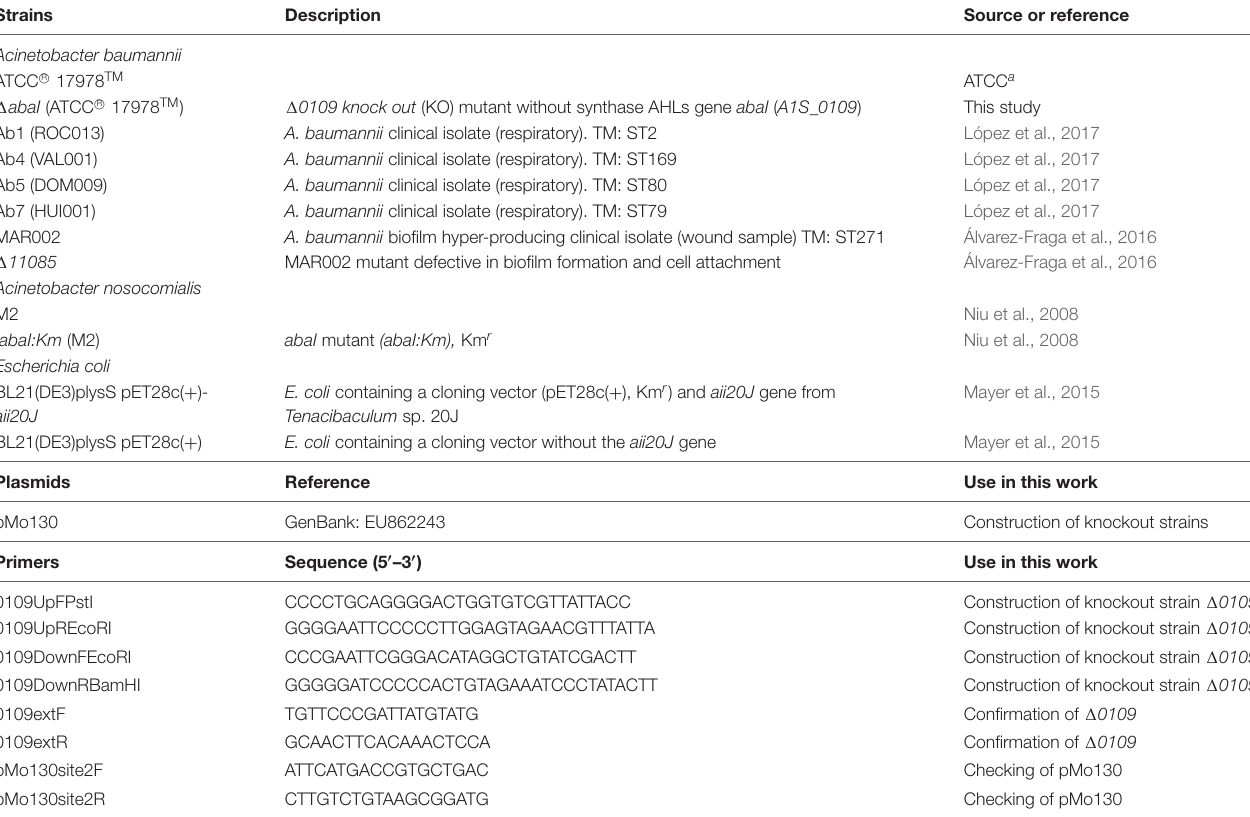
TABLE 1 | Bacterial strains, and primers used in this